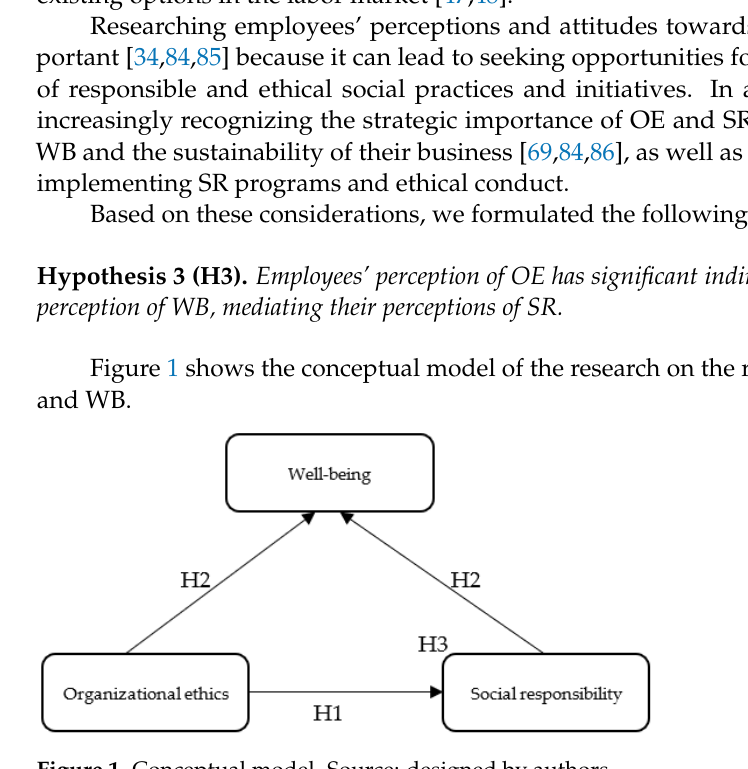
Figure 1. Conceptual model. Source: designed by authors.